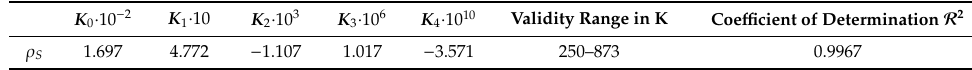
Table A2. Aluminum thermal conductivity correlation coefficients.